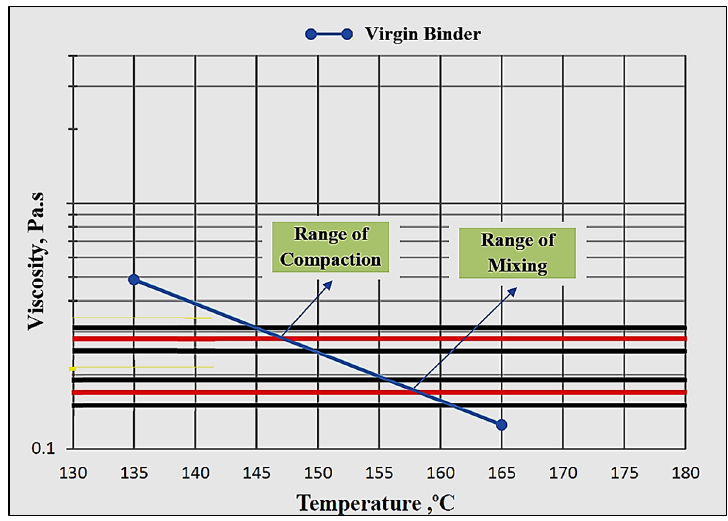
Figure 6. Rotational Brookfield viscometer.